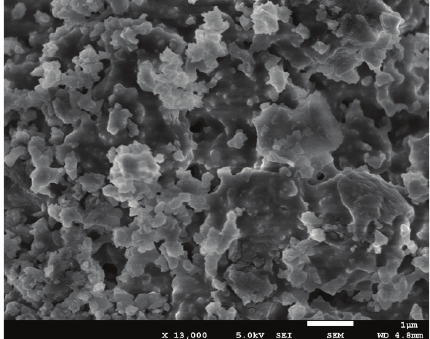
Figure 10: FESEM of ambient-cured OPSGPC incorporating pre- treated OPS with